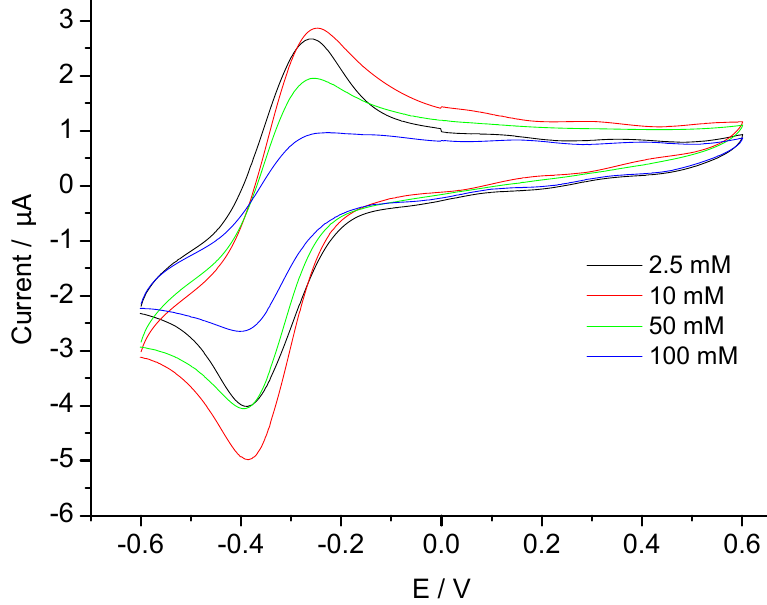
Figure 3. Cyclic voltammograms of MP-11-AuNP-CH/GCE in different buffer concentrations at pH